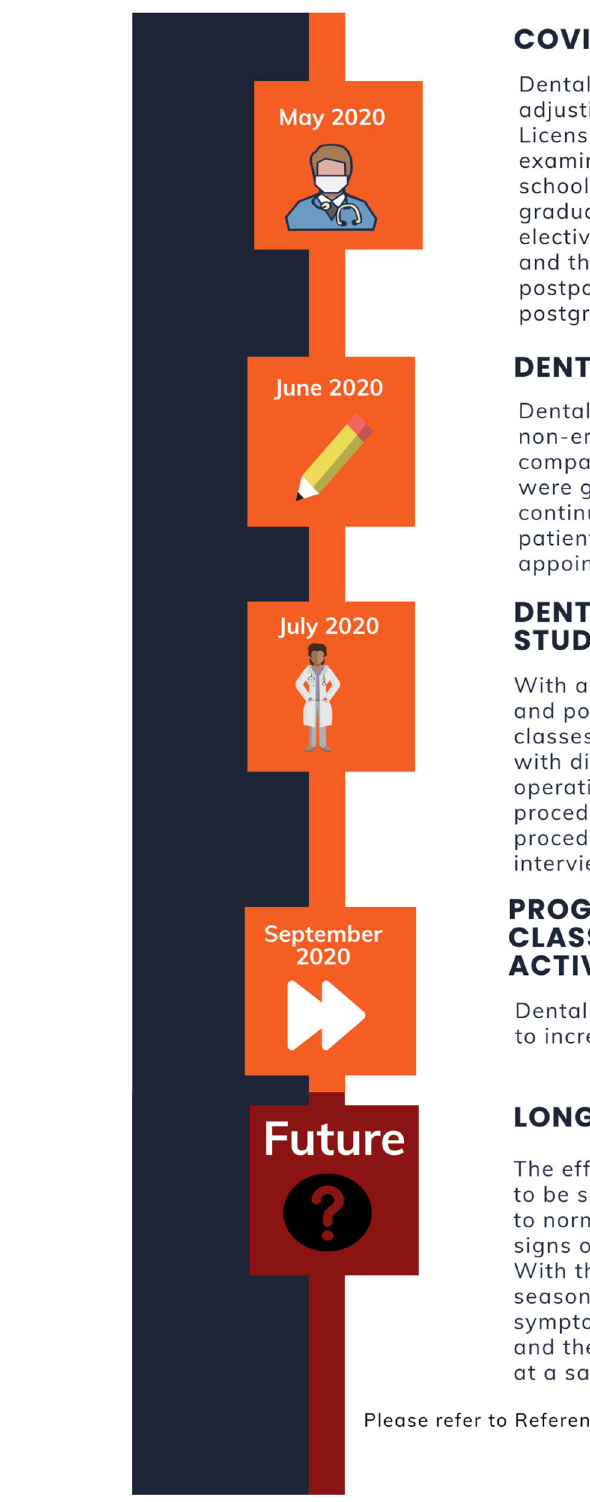
FIGURE 1 | Events pertaining to the interruption of dental education and practice in the United States.